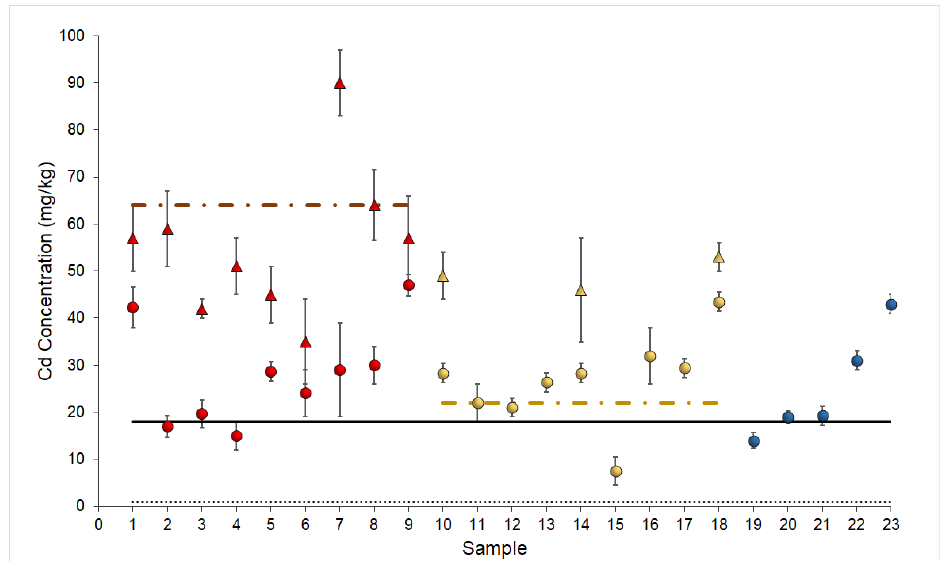
Figure 3. Cadmium concentration in soil (circles), rock samples (triangles), concentrations of organic (red dashed line) and chemical fertilizers (yellow dashed line). Red is for samples from Farm 1, yellow Farm 2 and blue Farm 3. The Cd critical threshold for human health risks (18 mg/kg; continuous line [36,37]) and the widely used threshold values for Cd concentrations in agricultural soils (1 mg/kg, dotted line; [9,27] and references therein) are indicated.